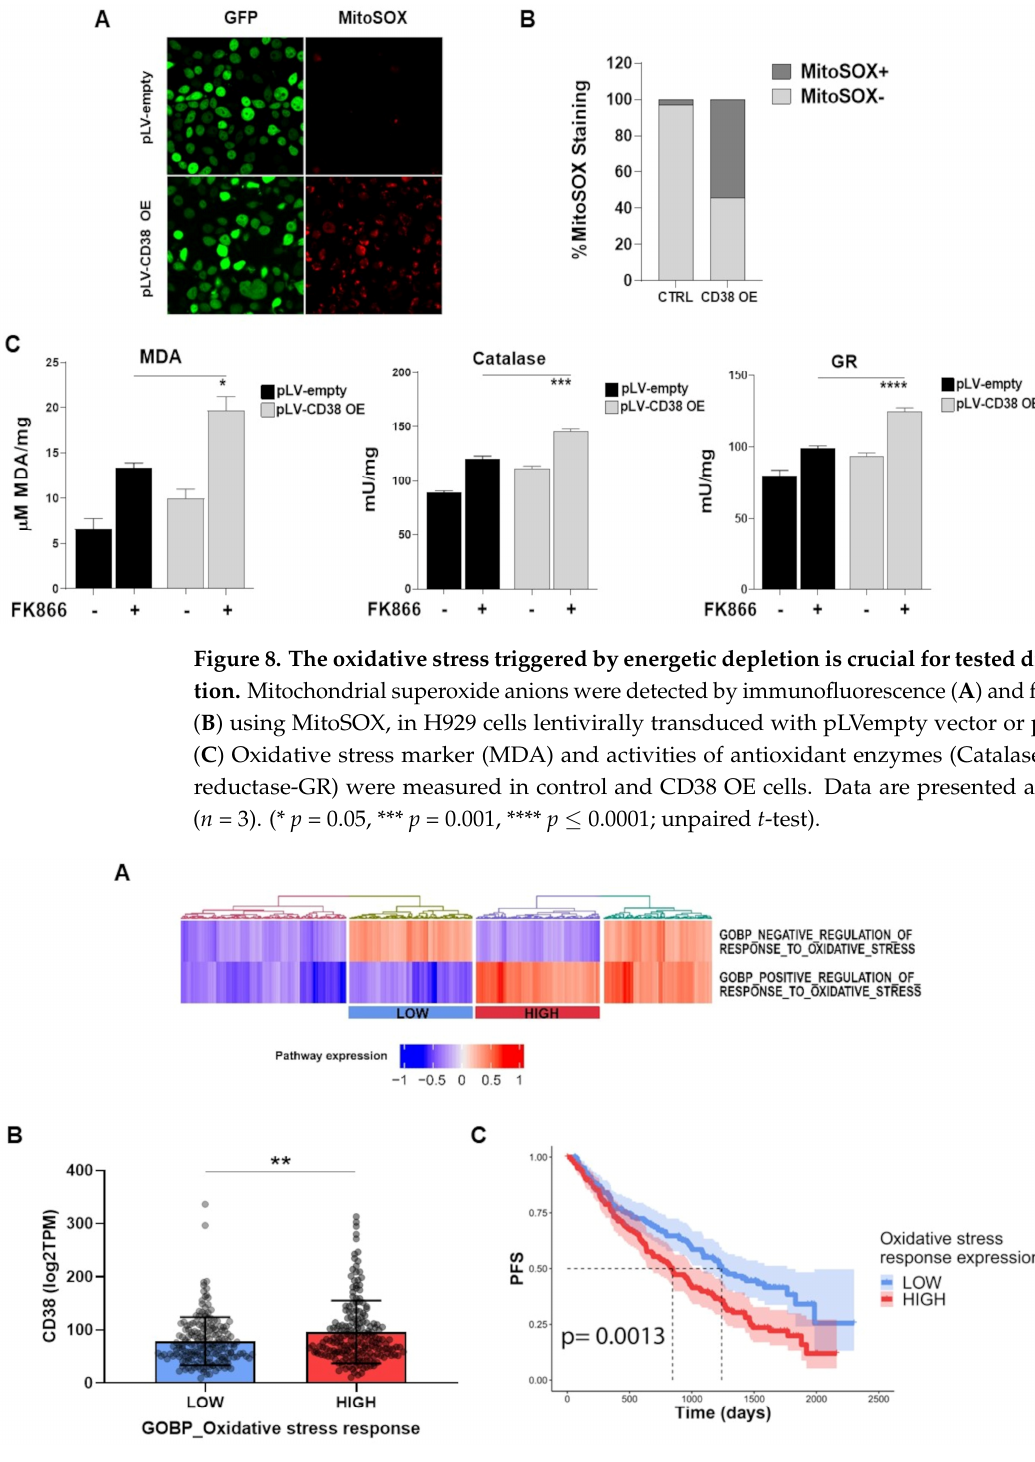
Figure 9. NAD + -depleting agents’ treatment could be beneficial for oxidative stress-prone MM patients. ( A ) Heatmap displaying enrichment in the CoMMpass dataset of indicated gene ontology terms; “LOW” and “HIGH” rectangles indicate groups of patients with a low and high expression of oxidative stress response, respectively. ( B ) Scatter-bar plot showing CD38 RNA levels in LOW and HIGH groups from panel E. ( C ) Kaplan–Meyer curves of the progression-free survival probability of the LOW and HIGH groups from panel A, p -value is indicated. Data are presented as mean ± S.D ( n = 3). (** p ≤ 0.01; unpaired t -test) .